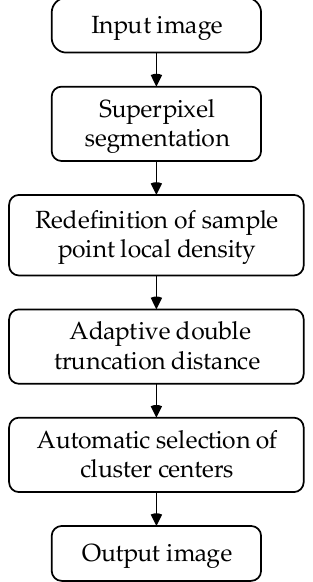
Figure 1. Flowchart of TSDPC.